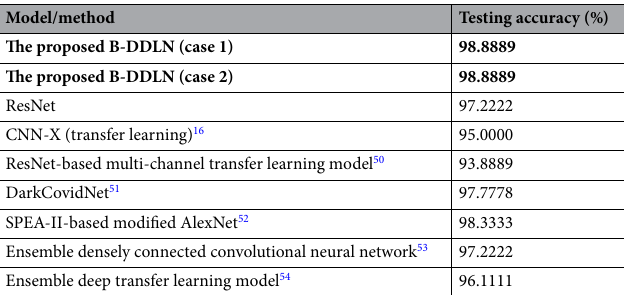
Table 4. Comparison results between B-DDLN and some existing state-of-the-art methods. The superior performance of the proposed B-DDLN diagnosis model are highlighted in bold.